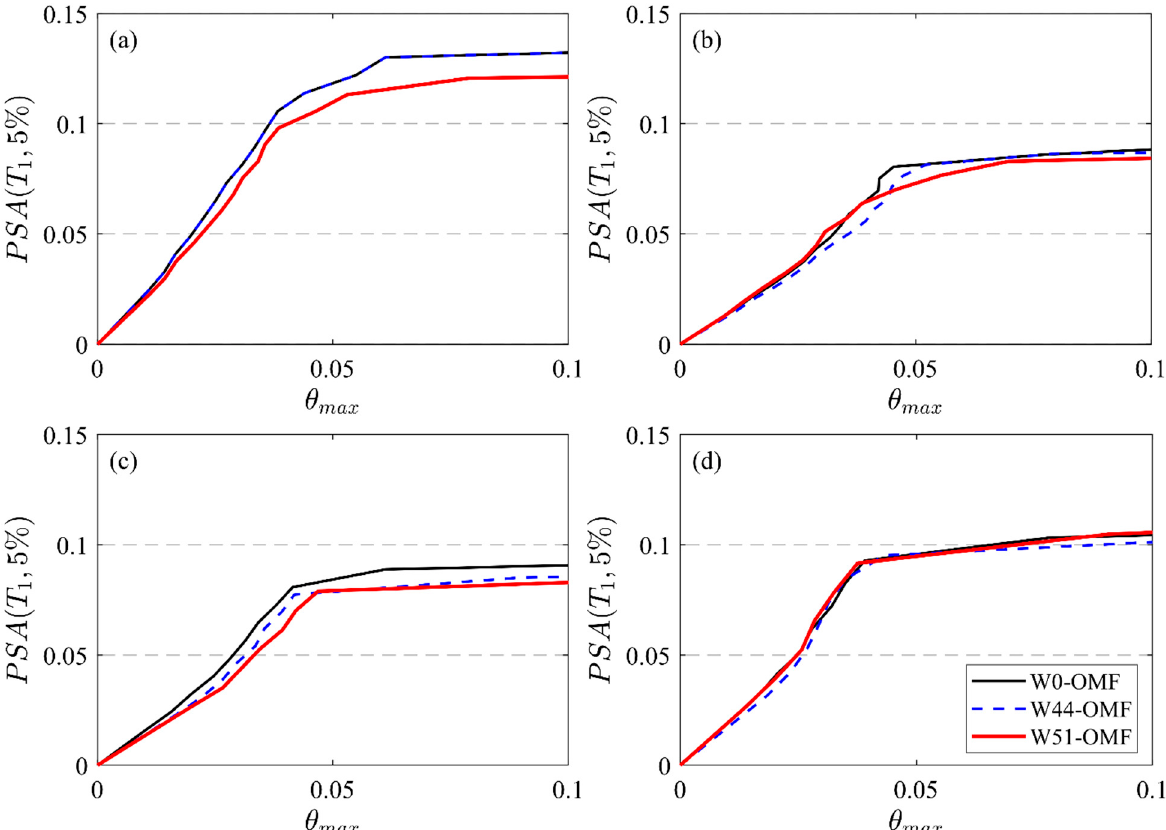
Figure 7. Median IDA curves for OMFs: ( a ) 9-story; ( b ) 12-story; ( c ) 15-story; ( d ) 18-story. Table 2. Parameters from pushover and IDA